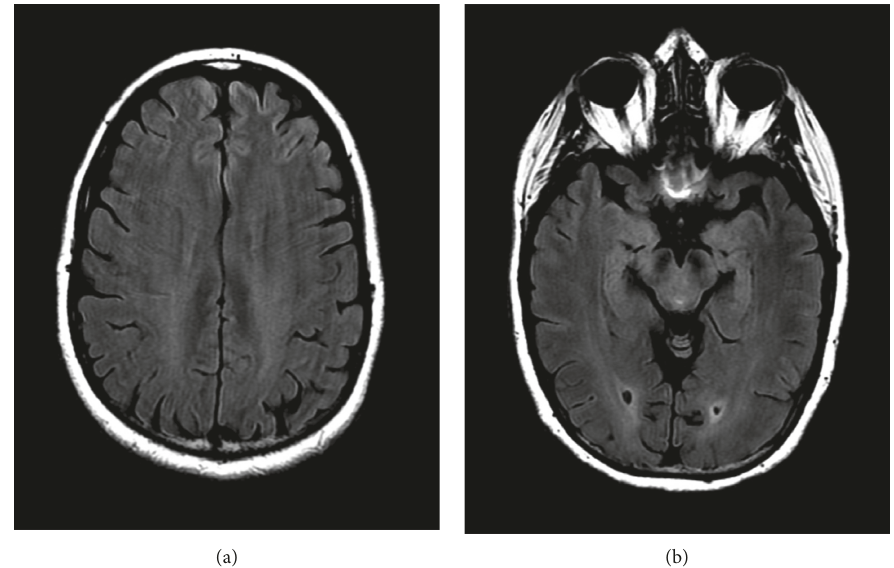
Figure 4: Axial FLAIR images of the brain demonstrating complete resolution of previously noted hyperintense signals in the (a) posterior right parietal lobe and (b) posterior occipital lobes